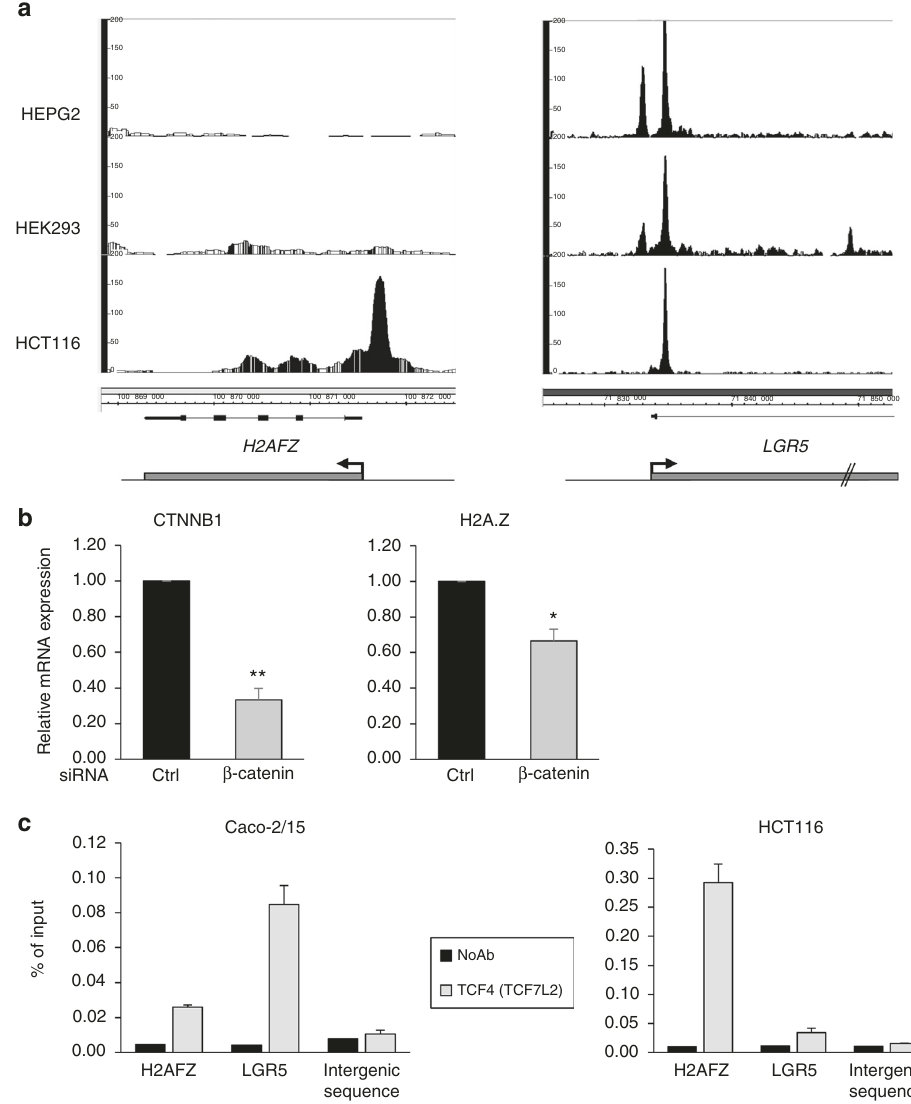
Fig. 7 H2A.Z is a target of the Wnt pathway. a Analysis of ChIP-seq data from Frietze et al. 36 for the binding of TCF7L2 on H2AFZ and LGR5 gene promoters in three cells lines (HEPG2, HEK293, and HCT116). Representation of peaks of enrichment were obtained using Integrated Genome Browser 9.0.2 (BioViz, https://bioviz.org). Note that the drawing scale is not identical due to the relative sizes of both genes. b HCT116 cells were transfected using β -catenin – targeting or control siRNA. 72 h later, total RNA was extracted and subjected to RT-qPCR analysis for expression of the indicated genes (calculated relative to β 2 M and RPLP0 (p0) mRNA level). The mean and standard errors are shown ( n = 3 independent experiments). Statistical analysis was done using Student ’ s t -Test (* p < 0.05; ** p < 0.02 vs control siRNA). c Chromatin from sub-con fl uent HCT116 and Caco-2/15 cells were harvested